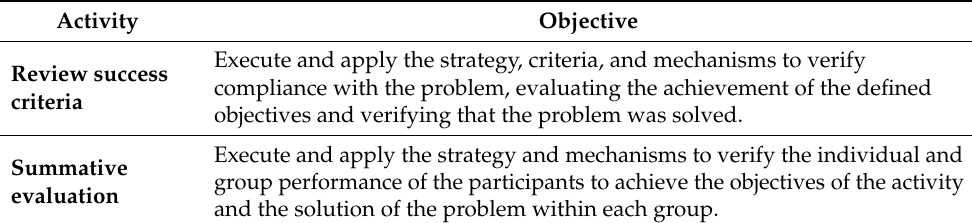
Table 3. The objective of each of the post-process activities .